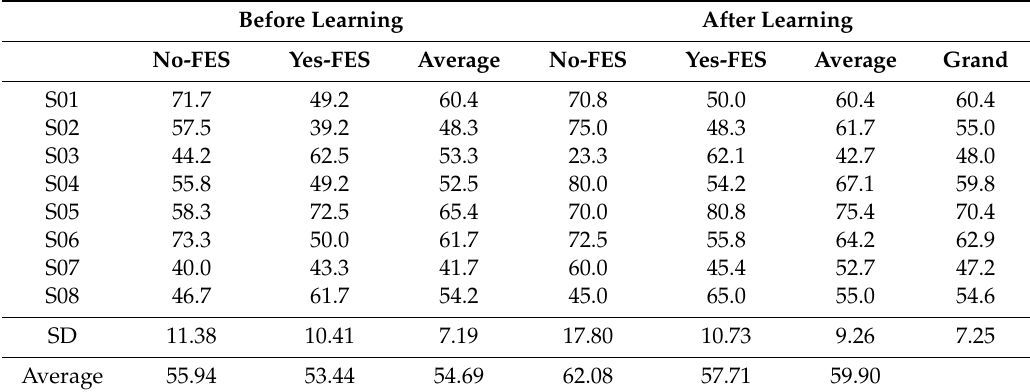
Table 3. Average completion rate of each independent variable (IV) (%).